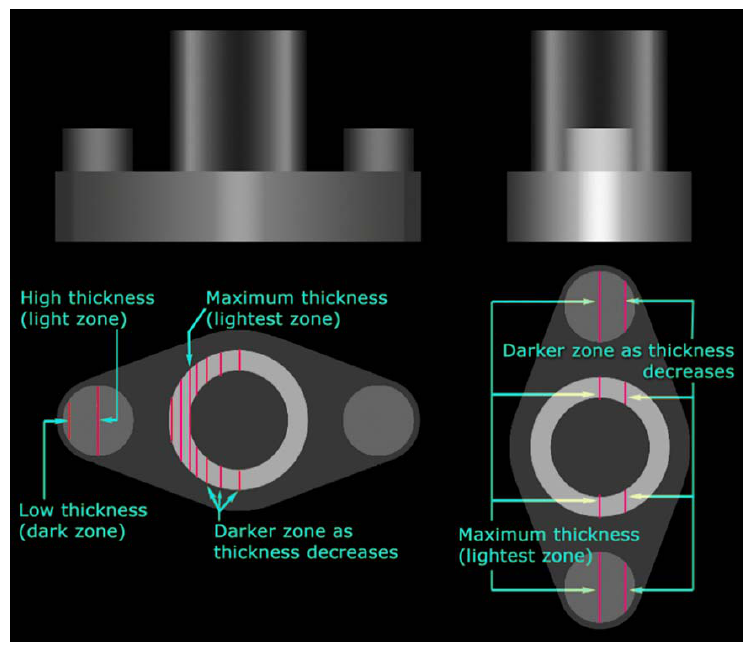
Figure 2. Graphical justification of the gray gradient of the part cylinders.